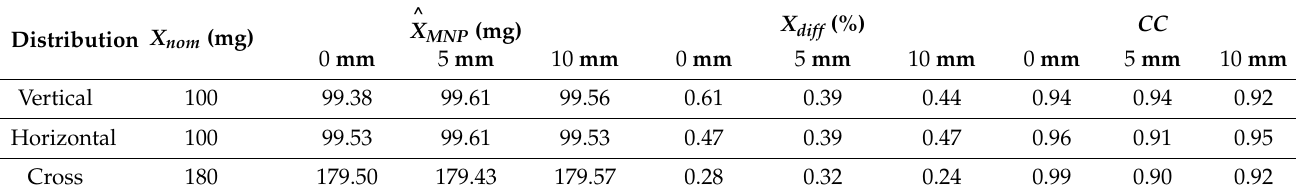
Figure 7. Reconstructed distributions of MNP loaded bars’ calculated signal. Note that lower voxels were used in the same FOV of 5 × 5 × 1 cm 3 , for a total of 100 voxels of 0.5 × 0.5 × 1 cm 3 . The first row shows the vertical distributions; the second row shows the horizontal distributions; and the third row shows the cross distributions. The columns indicate the distance between the bars’ surfaces. Table 3. CC and X dif f values for the ACB reconstructions of the calculated signal of bars’ geometries.